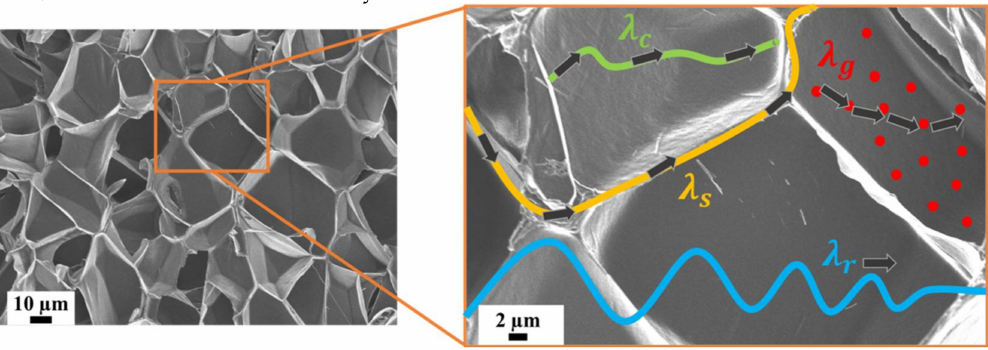
Figure 1. Schematic representation of heat transfers in foams.